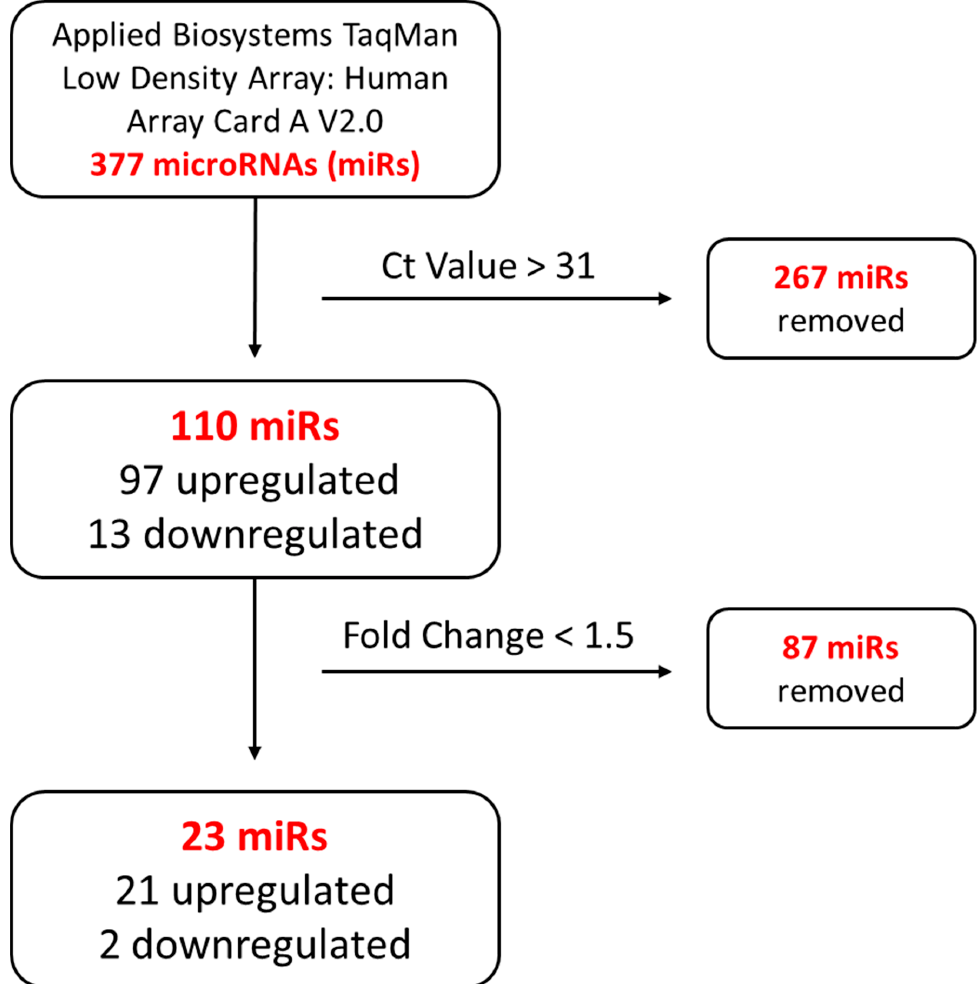
Figure 1. Systematic miRNA exclusion flow chart of miRNA microarray analysis. Ct: cycle threshold value.